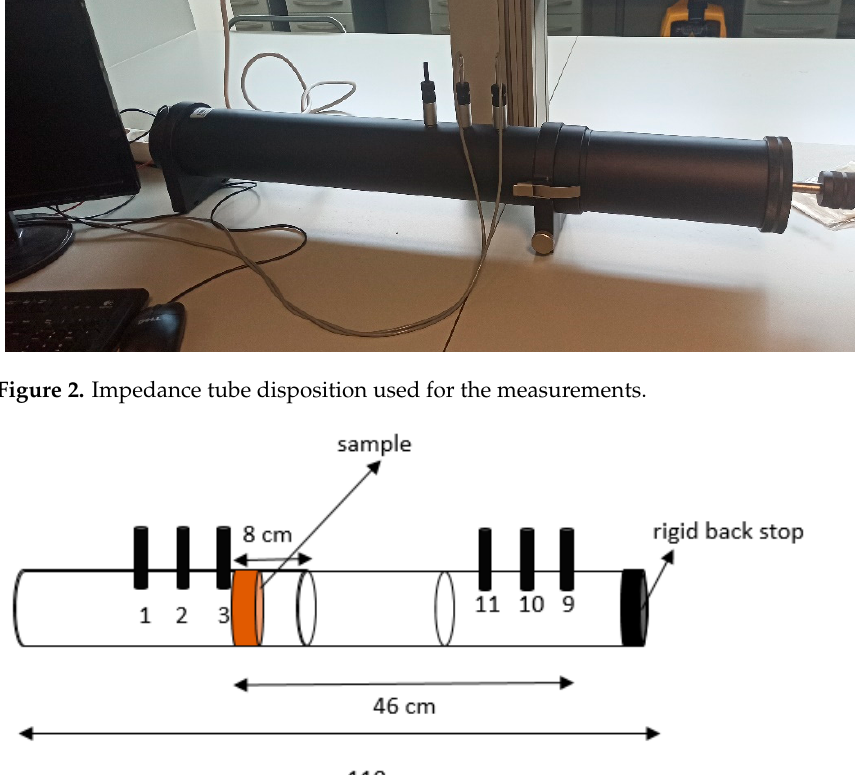
Figure 2. Impedance tube disposition used for the measurements.